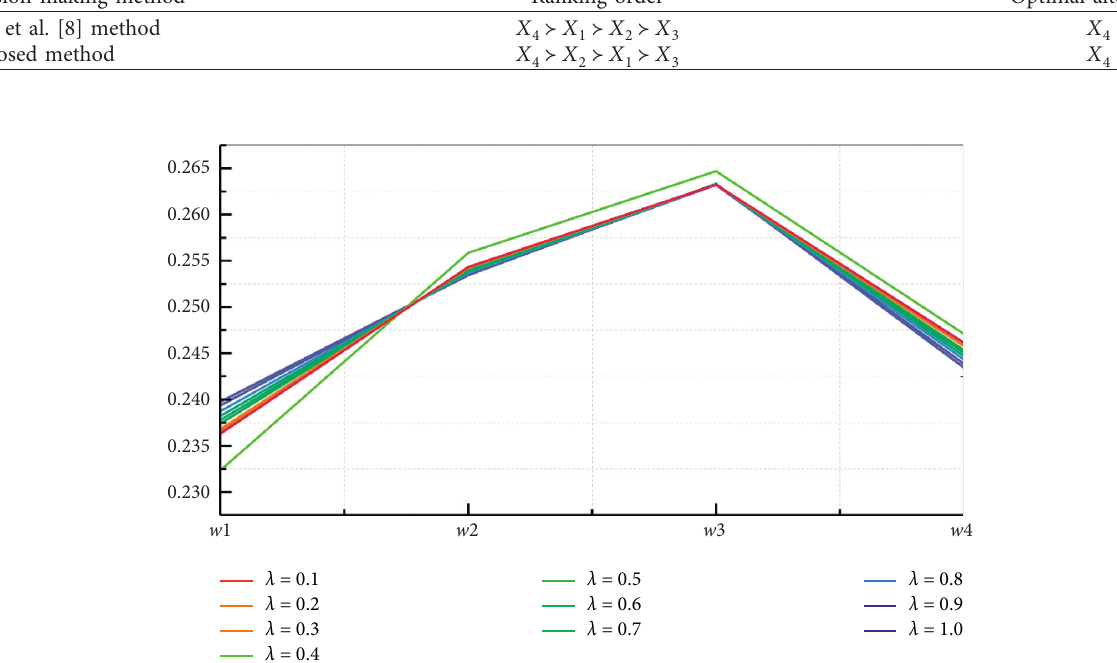
Figure 3: Values of criteria weights under different parameter λ